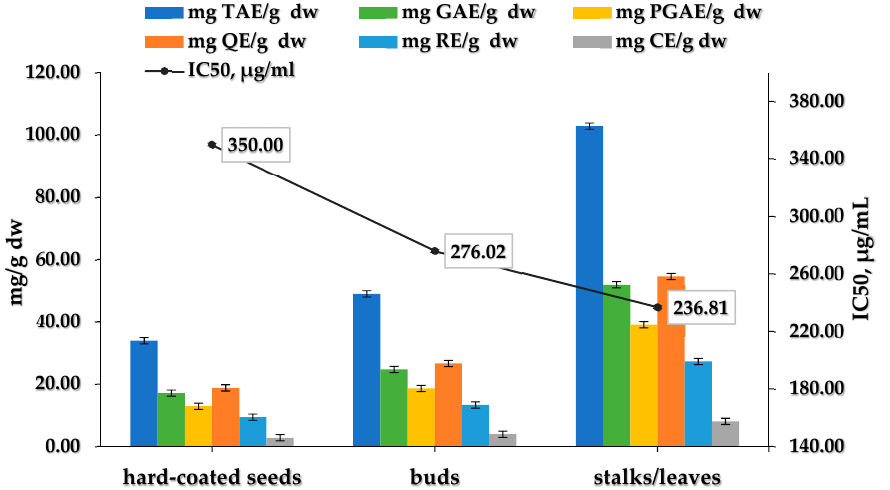
Figure 4. Evaluation of the TPC, TFC, and IC 50 of the Cistus incanus hard-coated seeds, buds and a mixture of stalks and leaves.